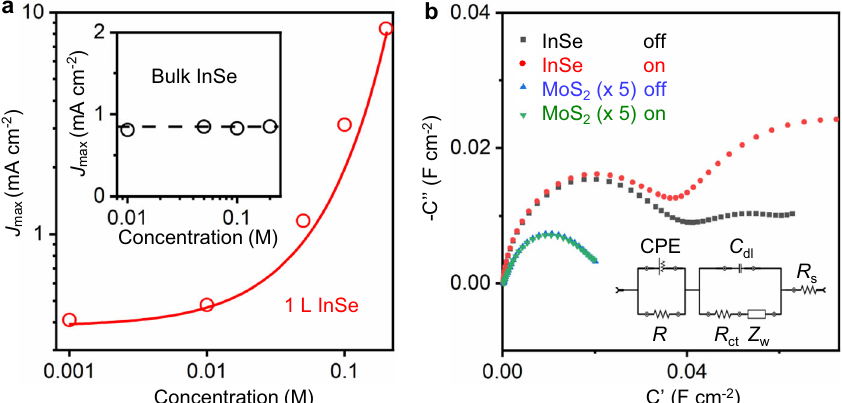
Fig. 2 Hydroxide ion adsorption on the InSe/Gr surface. a J max of a InSe/Gr monolayer device as a function of the NaOH concentration. Red dots are the experimental data. The red line is the prediction using Eq. (1) with a surface charge density of 1 mC m − 2 . The inset is J max of the bulk (thickness ~1 μ m) InSe/Gr device as a function of the NaOH concentration. The black dots are the experimental data. The black dashed line is to guide the eye. b Electrochemical impedance spectroscopy of InSe/Gr and MoS 2 /Gr monolayer devices when the light is on and off. The inset shows an equivalent electrical circuit of the InSe/Gr anode electrochemical interface. The fi rst semicircle close to origin represents the interface capacitance between the InSe/Gr and the Ti constant phase element (CPE), and the second semicircle represents the interface capacitance between the InSe/Gr and the PEC solution. For additional details, see Supplementary Methods, ‘ EIS ’